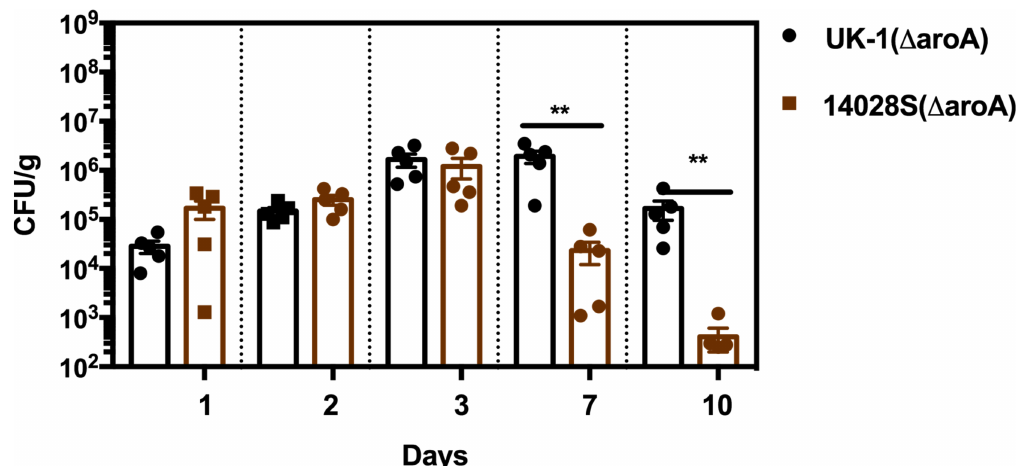
Fig 5. Vaccine strain detection in fecal pellets following oral immunization. BALB/c mice ( n = 5) were orally immunized with UK-1( Δ aroA ), 14028S( Δ aroA ) or BSG (mock). Fecal pellets were collected on days 0, 1, 2, 3, 7, and 10 post immunization for enumeration of bacterial shedding post vaccination. 14028S( Δ aroA ) titers in the fecal pellets declined significantly by day 7 and continued to decline at day 10. Mice vaccinated with UK-1( Δ aroA ) maintained significantly higher bacterial titers ( (cid:3)(cid:3) P (cid:20) 0.01) by day 10 post immunization (last time-point analyzed) when compared to 14028S( Δ aroA )-vaccinated mice.